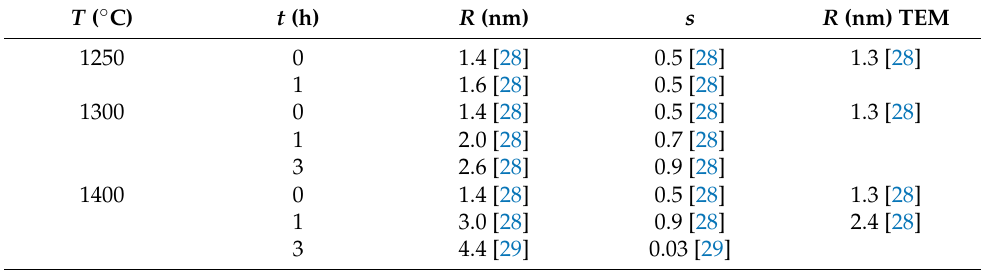
Table 3. Radius evolution with standard deviation s at 1250 ◦ C, 1300 ◦ C and 1400 ◦ C from [28] and [29]. Adapted from [28] with permission from